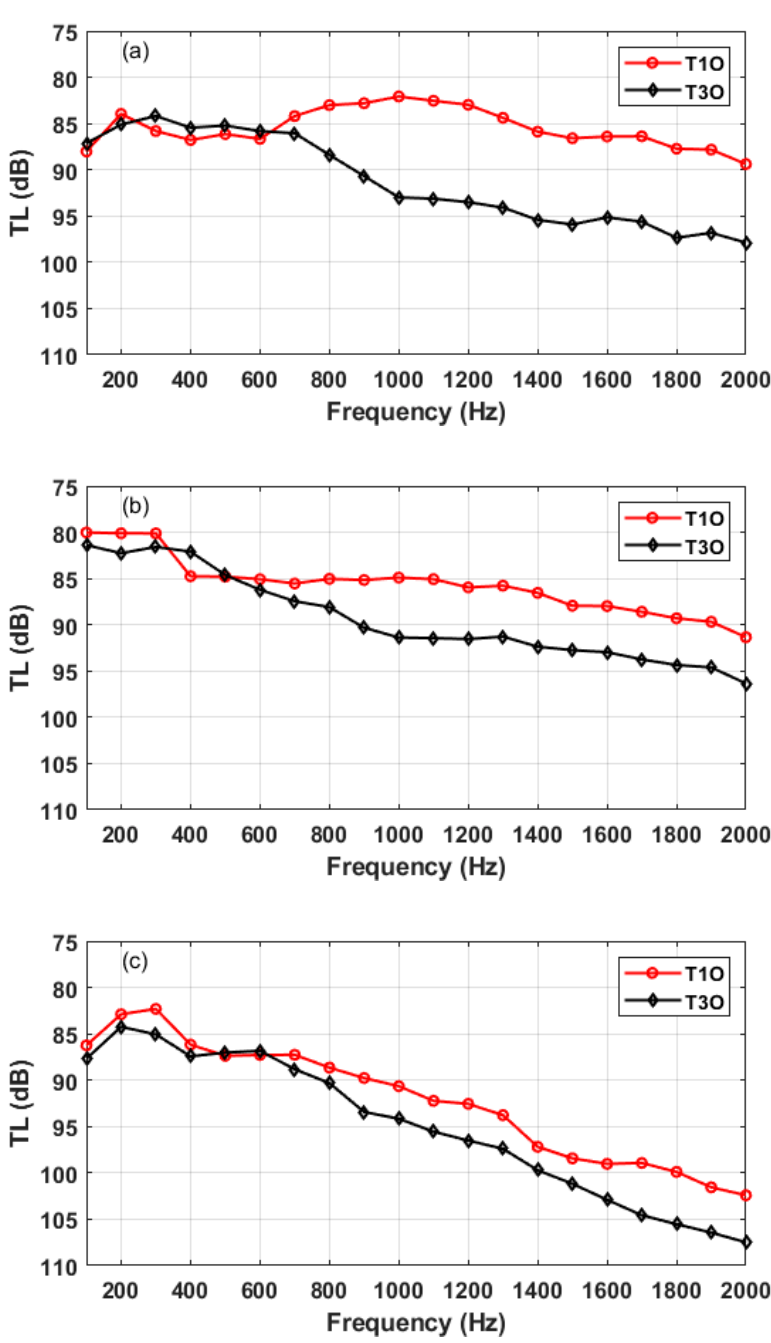
Figure 8. Comparison of experimental TLs of T1O and T3O at the range of 69.5 km for the central frequency 100–2000 Hz, source depth 7 m, and receiver depth 11 m ( a ), 37 m ( b ), and 71 m ( c ).